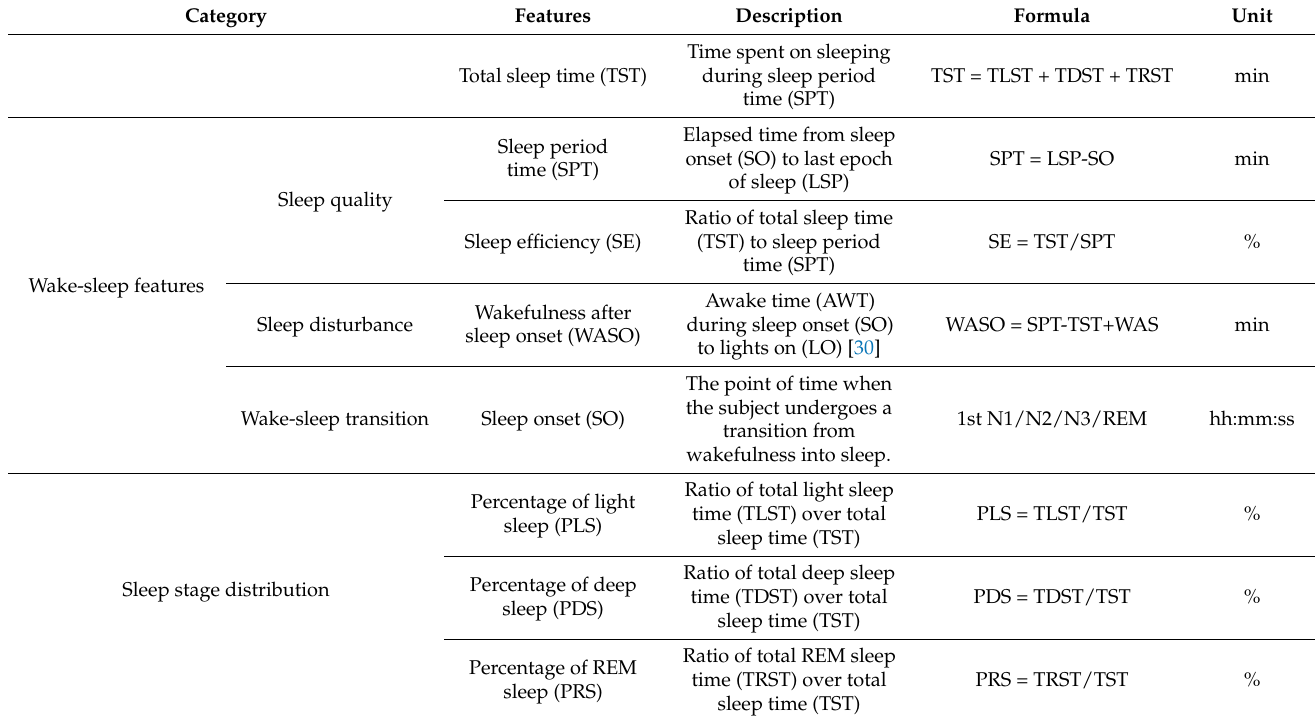
Table 2. Derivation of wake-sleep features and sleep stage distribution from the timing features defined in Figure 2.